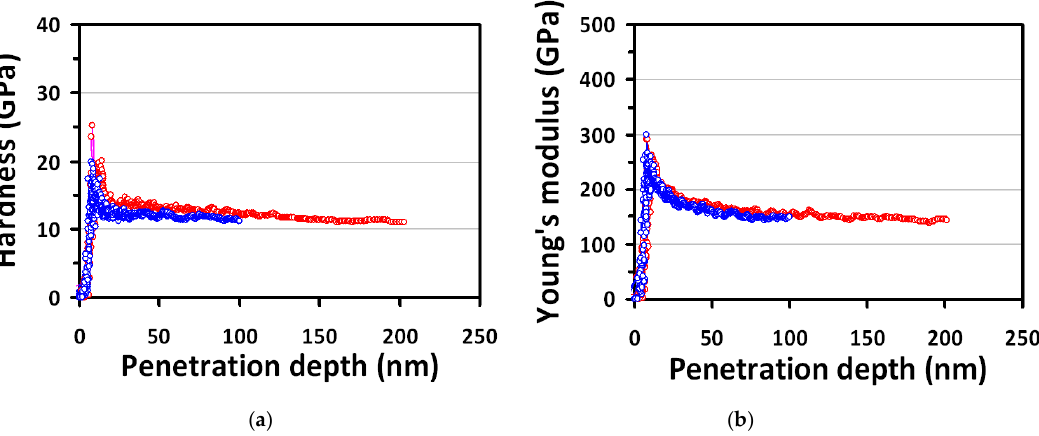
Figure 2. Hardness and Young’s modulus of GaP(100) single-crystal. ( a ) the hardness and ( b ) Young’s modulus as a function of penetration depth (100 and 200 nm) from nanoindentation CSM results. Table 1. The hardness and Young’s modulus of various semiconductor materials.